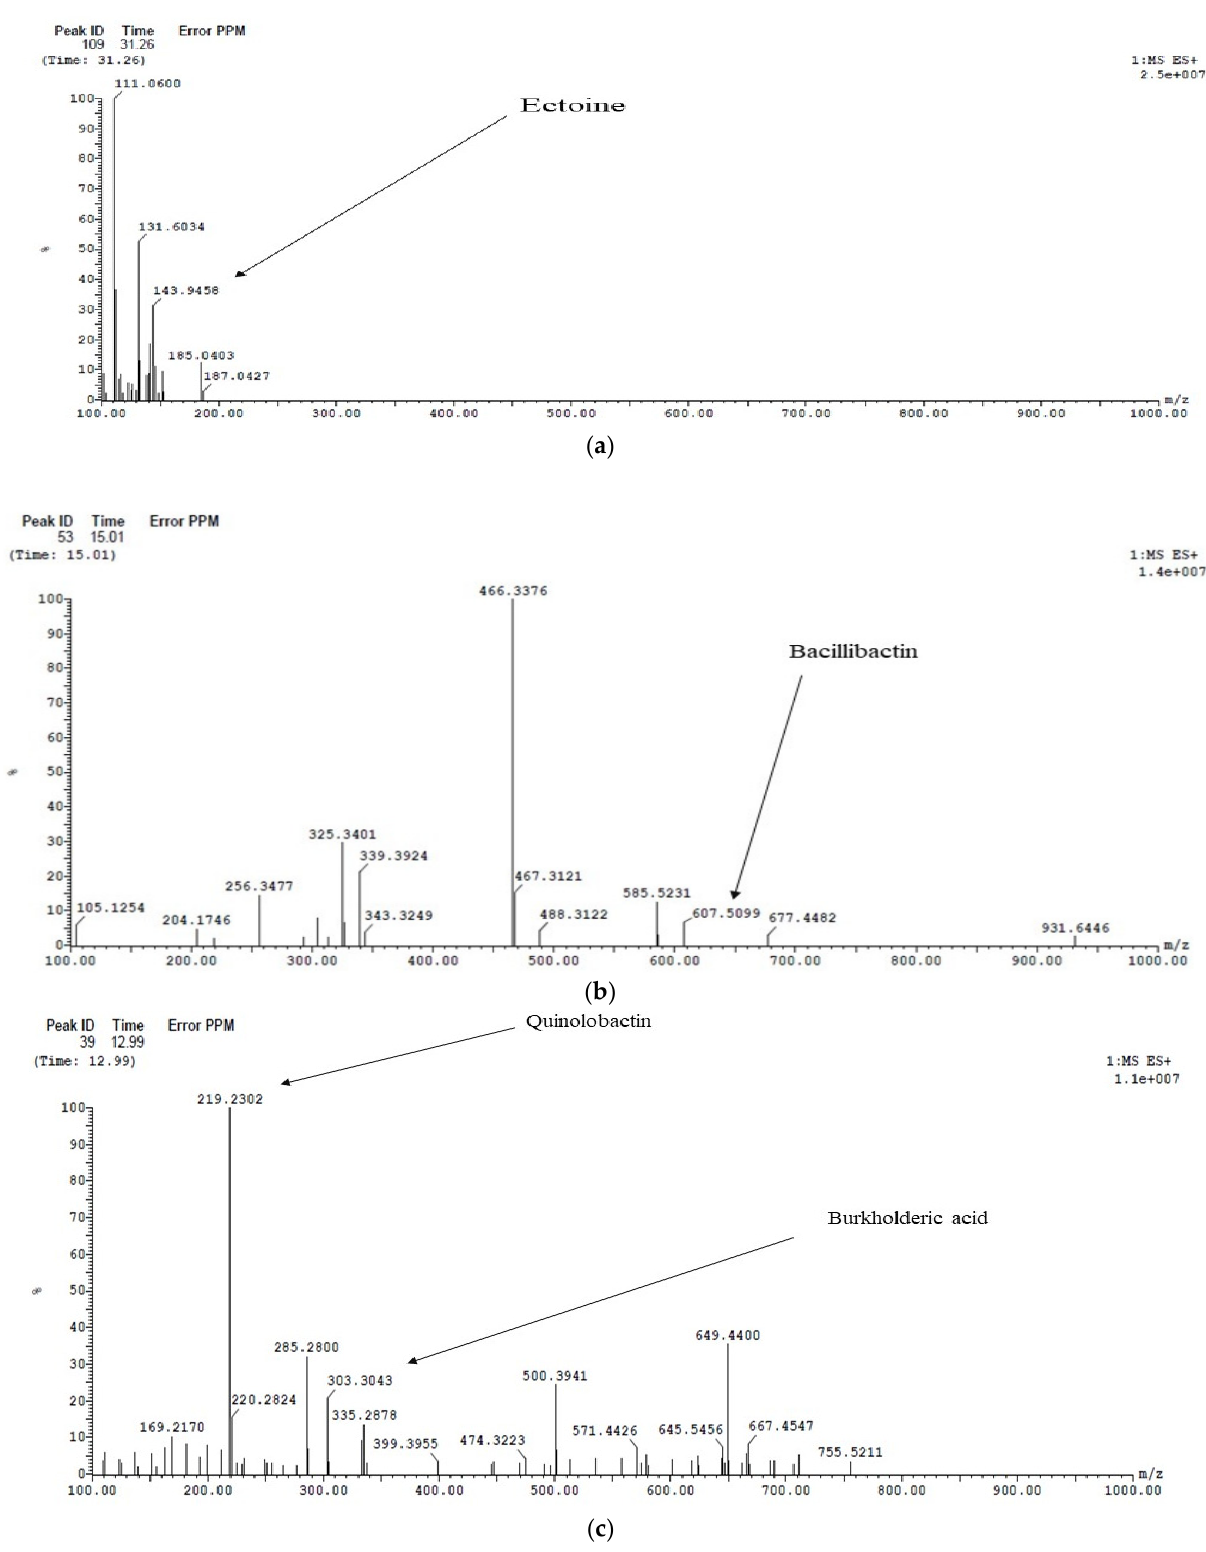
Figure 2. LC/MS analysis of a cell free ethyl acetate extract of A. faecalis isolate MZ921504 ( a ) detection of ectoine, ( b ) detection of bacillibactin, ( c ) detection of quinolobactin and Burkholderic acid.